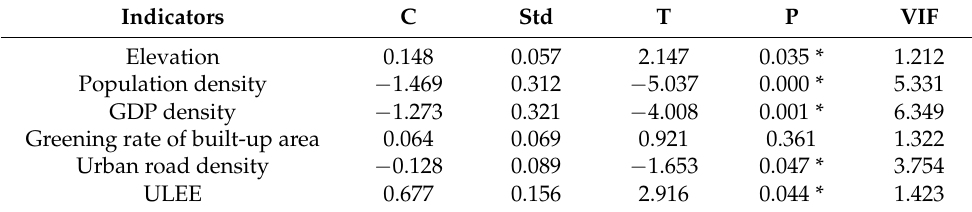
Table 3. Results of